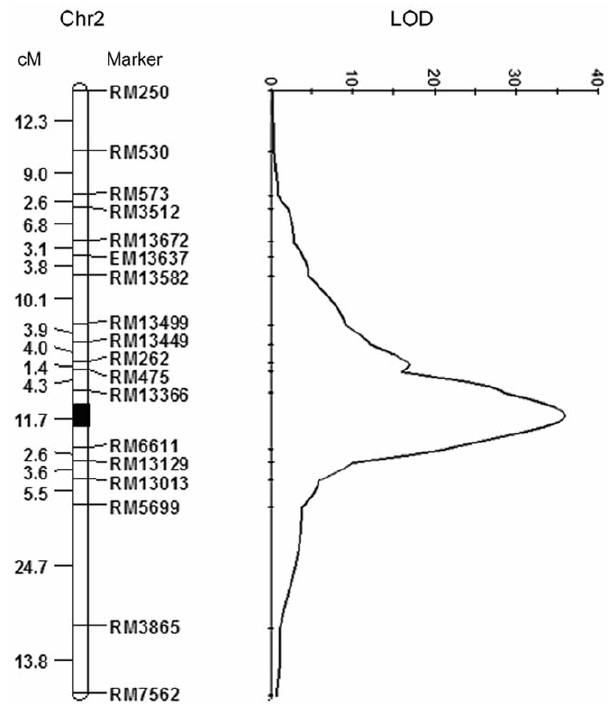
Figure 3. Genetic linkage map of rice resistant starch on chromosome 2 for sbe3-rs , genetic distance (Kosambi, centi- Morgan) and SSR marker name on the left and right of the chromosome, respectively and highlighted region for the estimated position of seb3-rs .